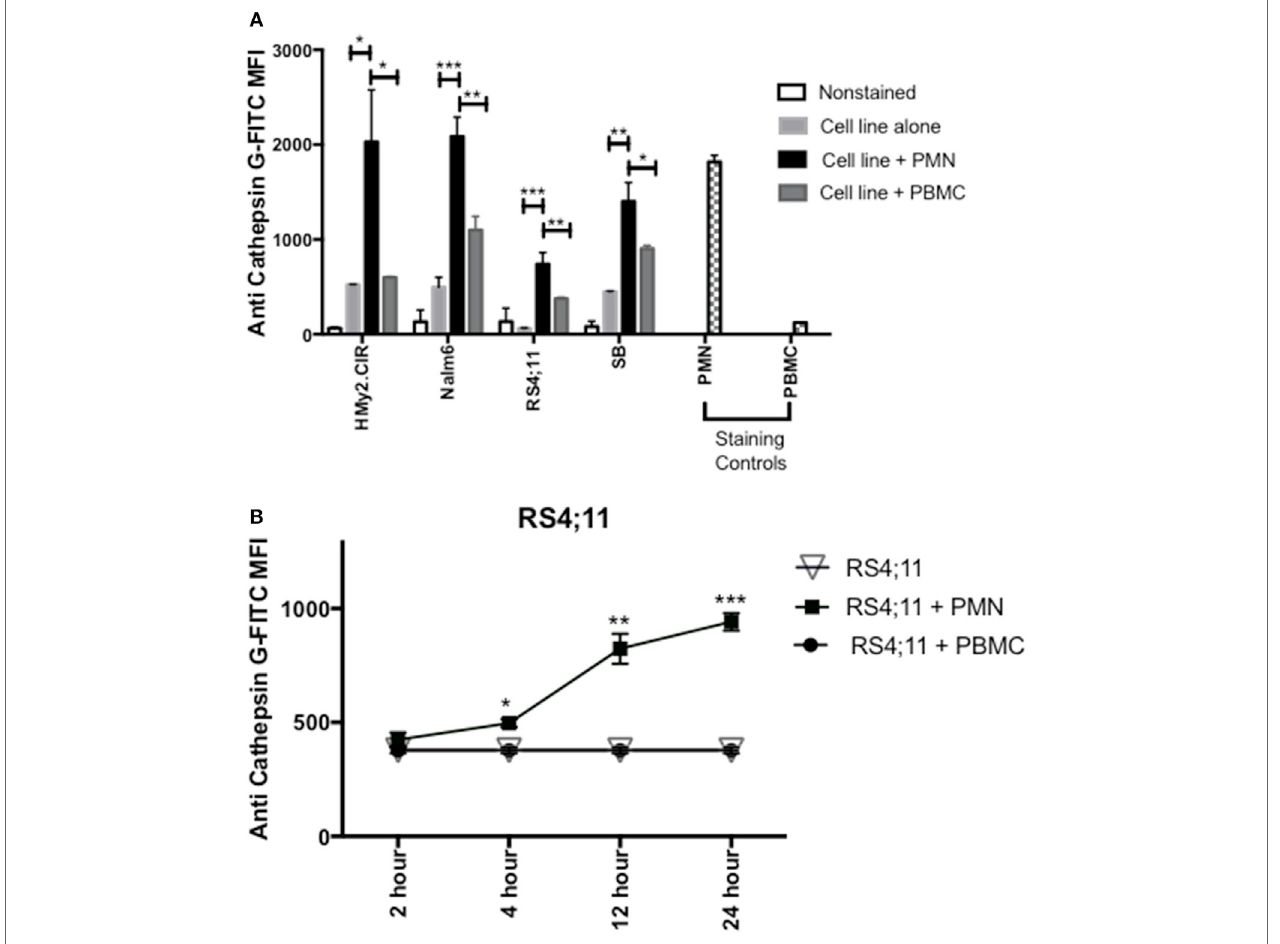
FigUre 3 | PMN-associated Cathepsin G (CG) is taken up by B-ALL cell lines. (a) Flow cytometry detected intracellular CG in B-ALL cell lines after coculture with whole PMN at a ratio of 3:1 for 12 h. Cells were intracellularly stained with anti-CG antibody. PMN and peripheral blood mononuclear cells (PBMC) were used as positive and negative staining controls, respectively. * P < 0.05; ** P < 0.01; *** P < 0.001. (B) RS4;11 cells were cocultured with whole PMN or PBMC at a ratio of 3:1 for 2, 4, 12, and 24 h and analyzed by flow cytometry for intracellular uptake of CG using anti-CG antibody. Cells cultured in the presence or absence of PBMC were used as negative controls. PMN and PBMC were used as positive and negative staining controls, respectively. Flow cytometry indicated that uptake of extracellular CG occurs in HMY2.CIR, Nalm6, and RS4;11 cell lines. Graphs display the mean ± SEM fold increase in median fluorescence intensity (MFI). Data represent triplicate wells from four independent experiments. * P < 0.05; ** P < 0.01; *** P <